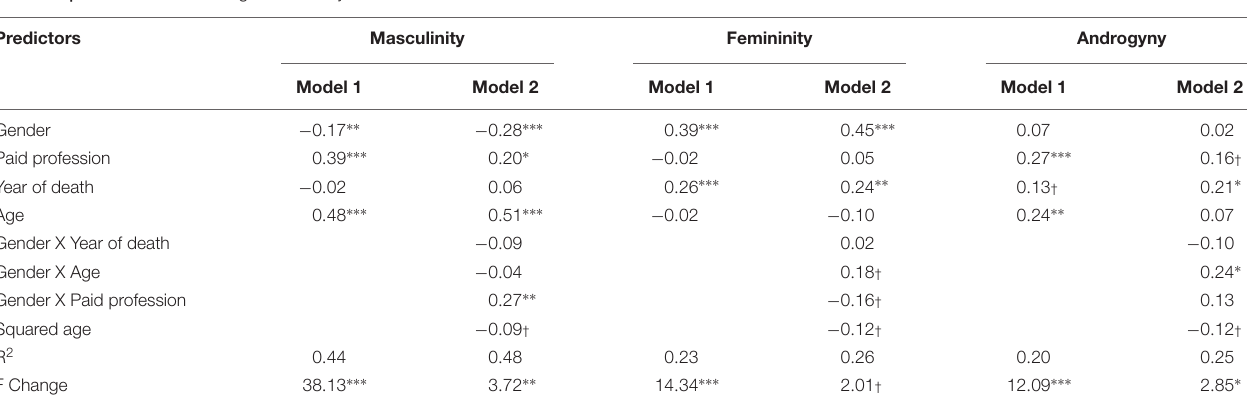
TABLE 3 | Results of the OLS regression analyses.